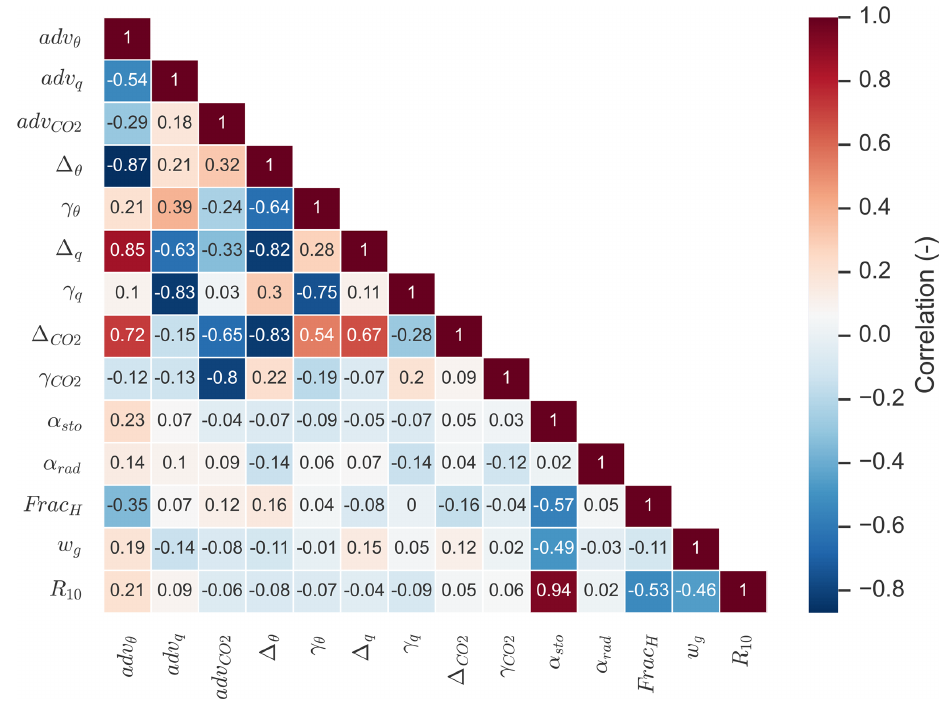
Figure 7. Correlation matrix for the optimised state parameters for the Cabauw case. The shown correlations are marginal correlations and not partial